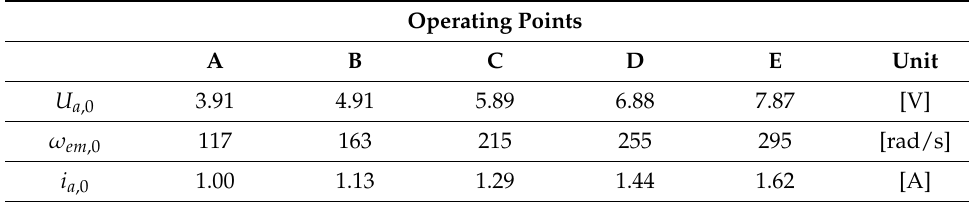
Table 4. Evaluated operating points.